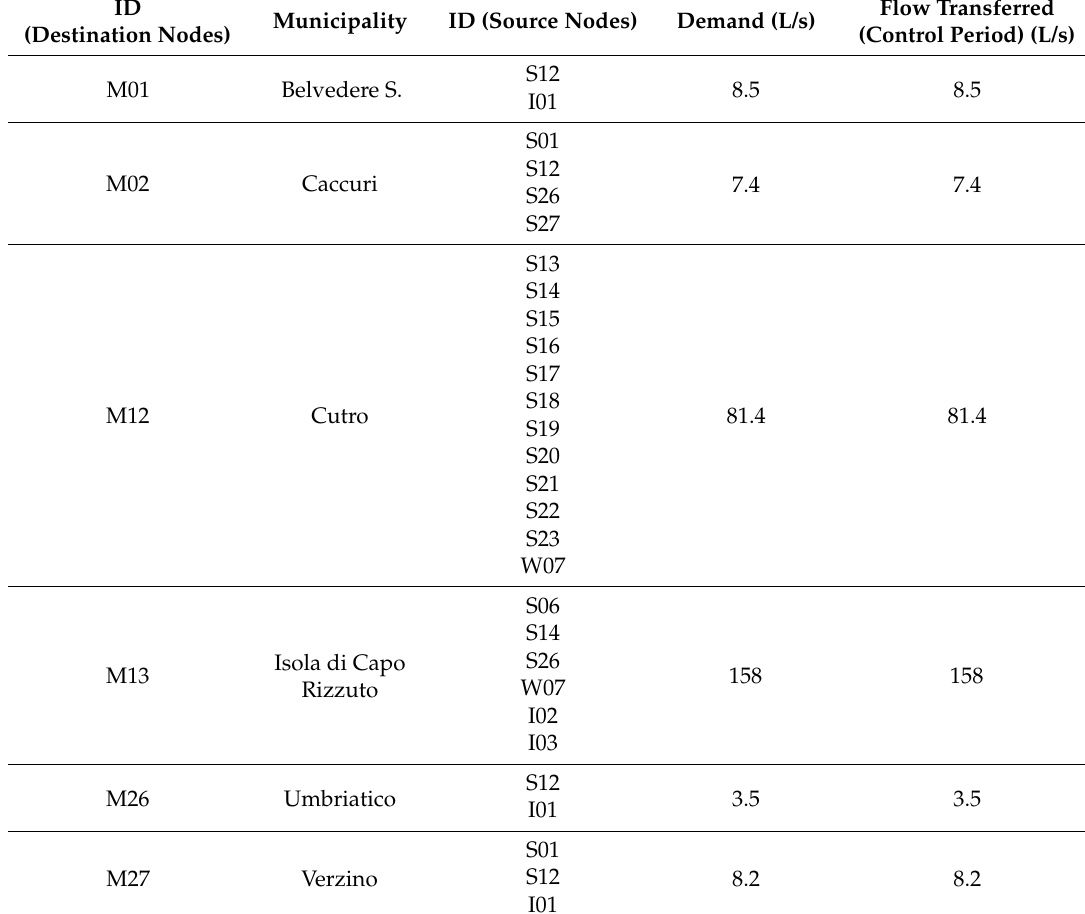
Table 5. Schematic example of the results for the climate change